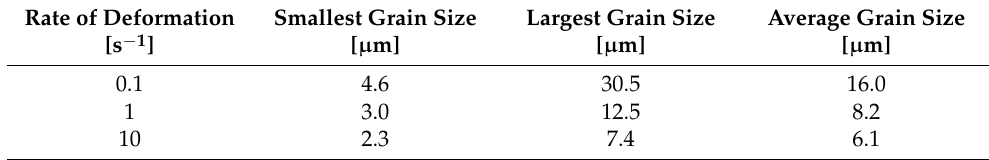
Figure 8. Primary austenite grain boundaries generated by the ARPGE program after continuous compression of samples at 1100 ◦ C for deformation 0.69, at the rate: 0.1 s − 1 ( a ), 1 s − 1 ( b ), 10 s − 1 ( c ). Table 3. Results of grain size measurements as a function of strain rate; deformation value: 0.69. Rate of